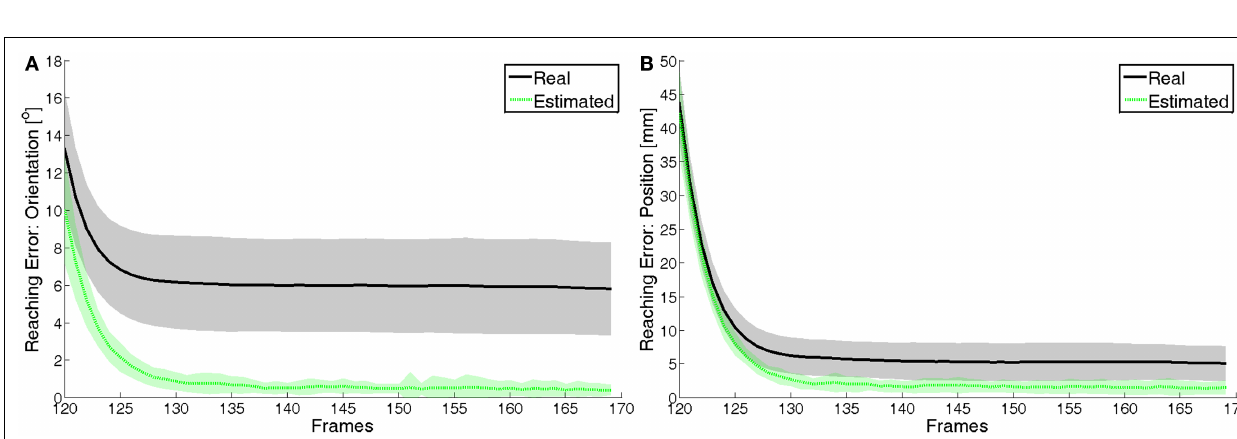
Frontiers in Robotics and AI |